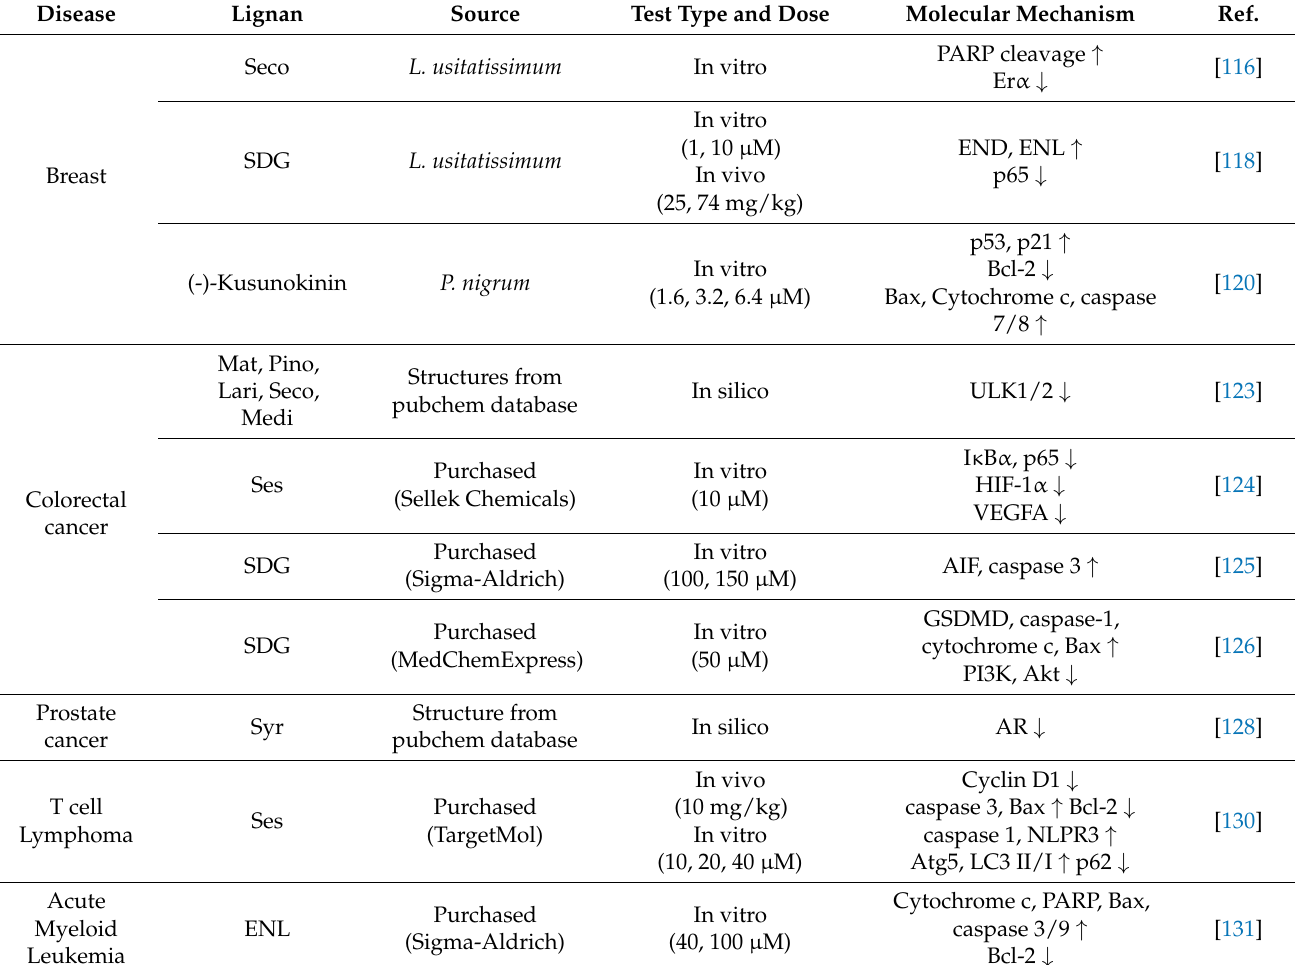
Table 2. Summary of the results of published pharmacological experiments conducted to evaluate the effects of lignans in